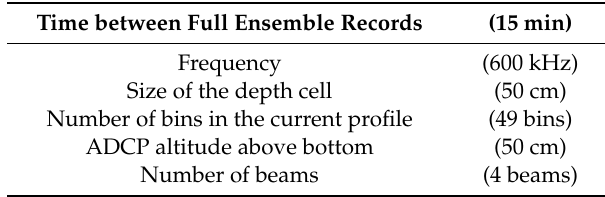
Table 7. The spectral analysis parameters of the ADCP. Table 6. ADCP configuration.